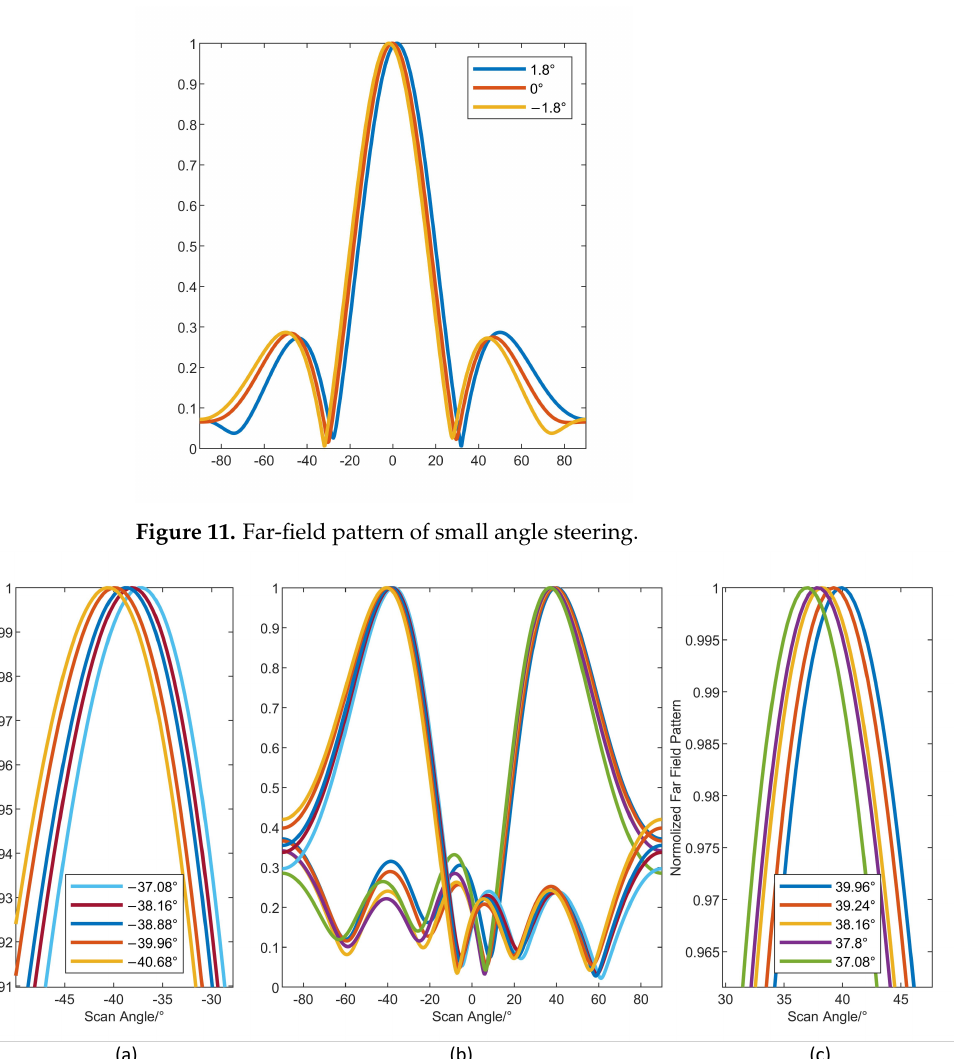
Figure 12. Far-field pattern of wide and fine beam steering ( a ) Scan details around − 40°; ( b ) accurate angular scanning over a wide range of ± 40° ( c ) scan details around 40°; ( c ) Scan details around